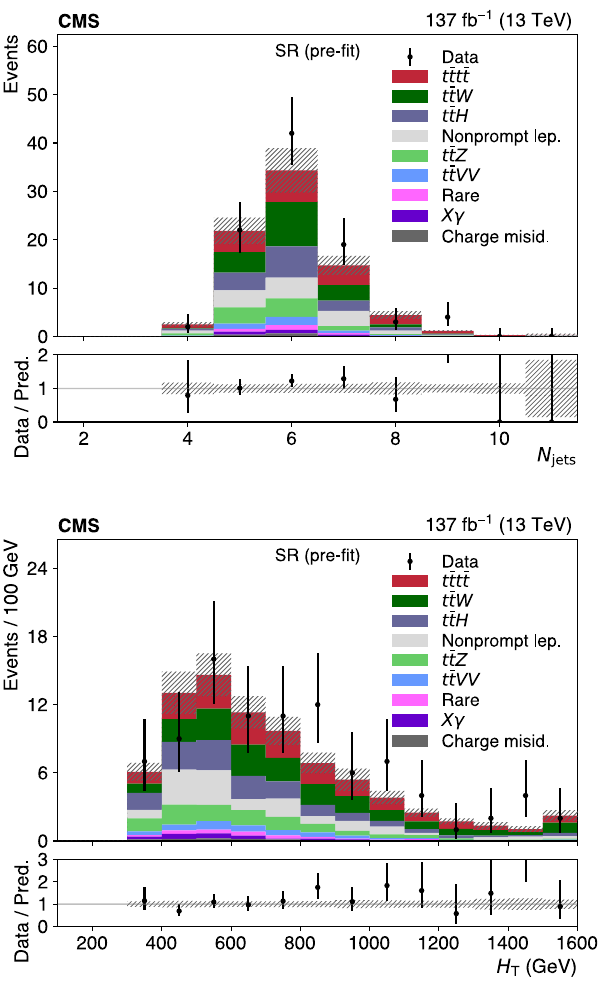
Fig. 2 Distributions of N jets (upper left), N b (upper right), H T (lower left), and p miss (lower right) in the summed SRs (1–14), before fitting to T data, where the last bins include the overflows. The hatched areas repre- sentthetotaluncertaintiesintheSMsignalandbackgroundpredictions.